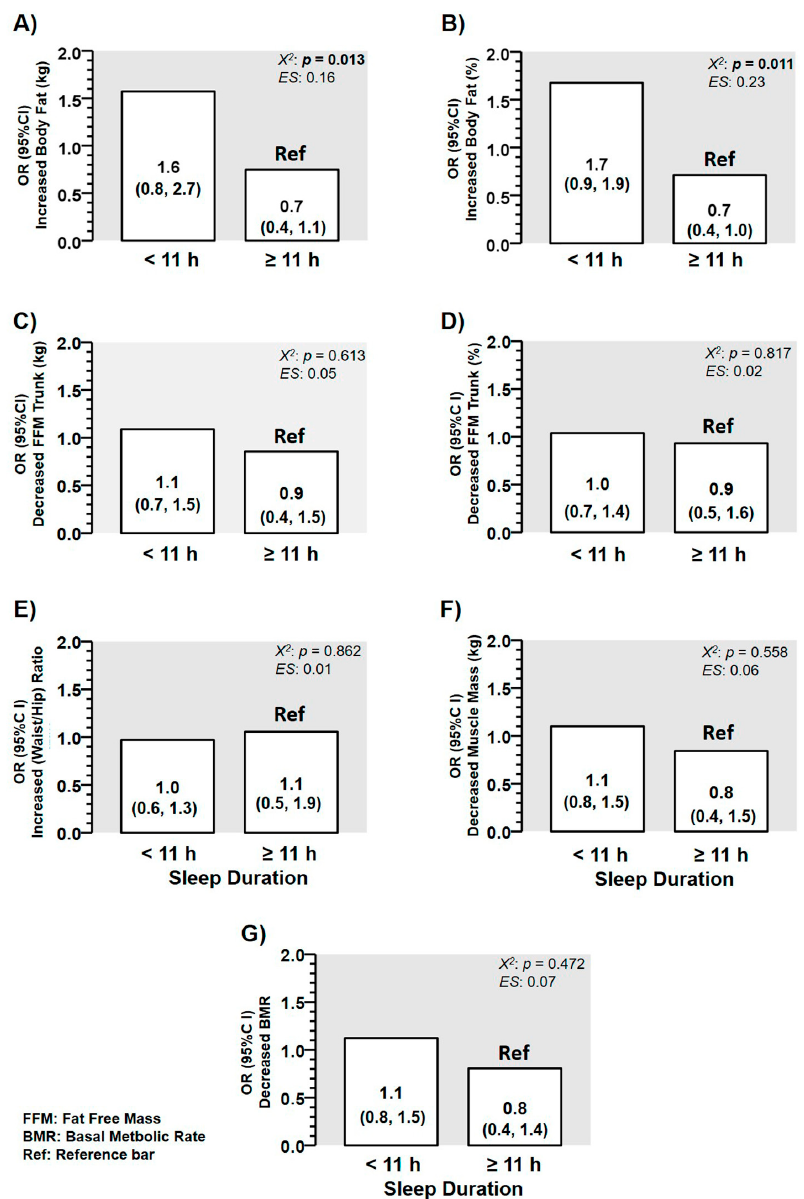
Figure 5. Characteristics of different body composition outcomes in a sample of Chilean preschoolers ( n = 99) according with their odds ratio (OR) for suffering or not the condition of ( A ) OR for suffering from increased “body fat in kg”, ( B ) OR for suffering from increased “body fat in percentage”, ( C ) OR for suffering from “decreased fat free mass in the trunk in kg”, ( D ) OR for suffering from “decreased fat-free mass in the trunk in percentage”, ( E ) OR for suffering from “increased waist to height ratio”, ( F ) OR for suffering from decreased muscle mass”, ( G ) OR for suffering from “decreased basal metabolic rate at rest”. (ES) Denotes Cohen d effect